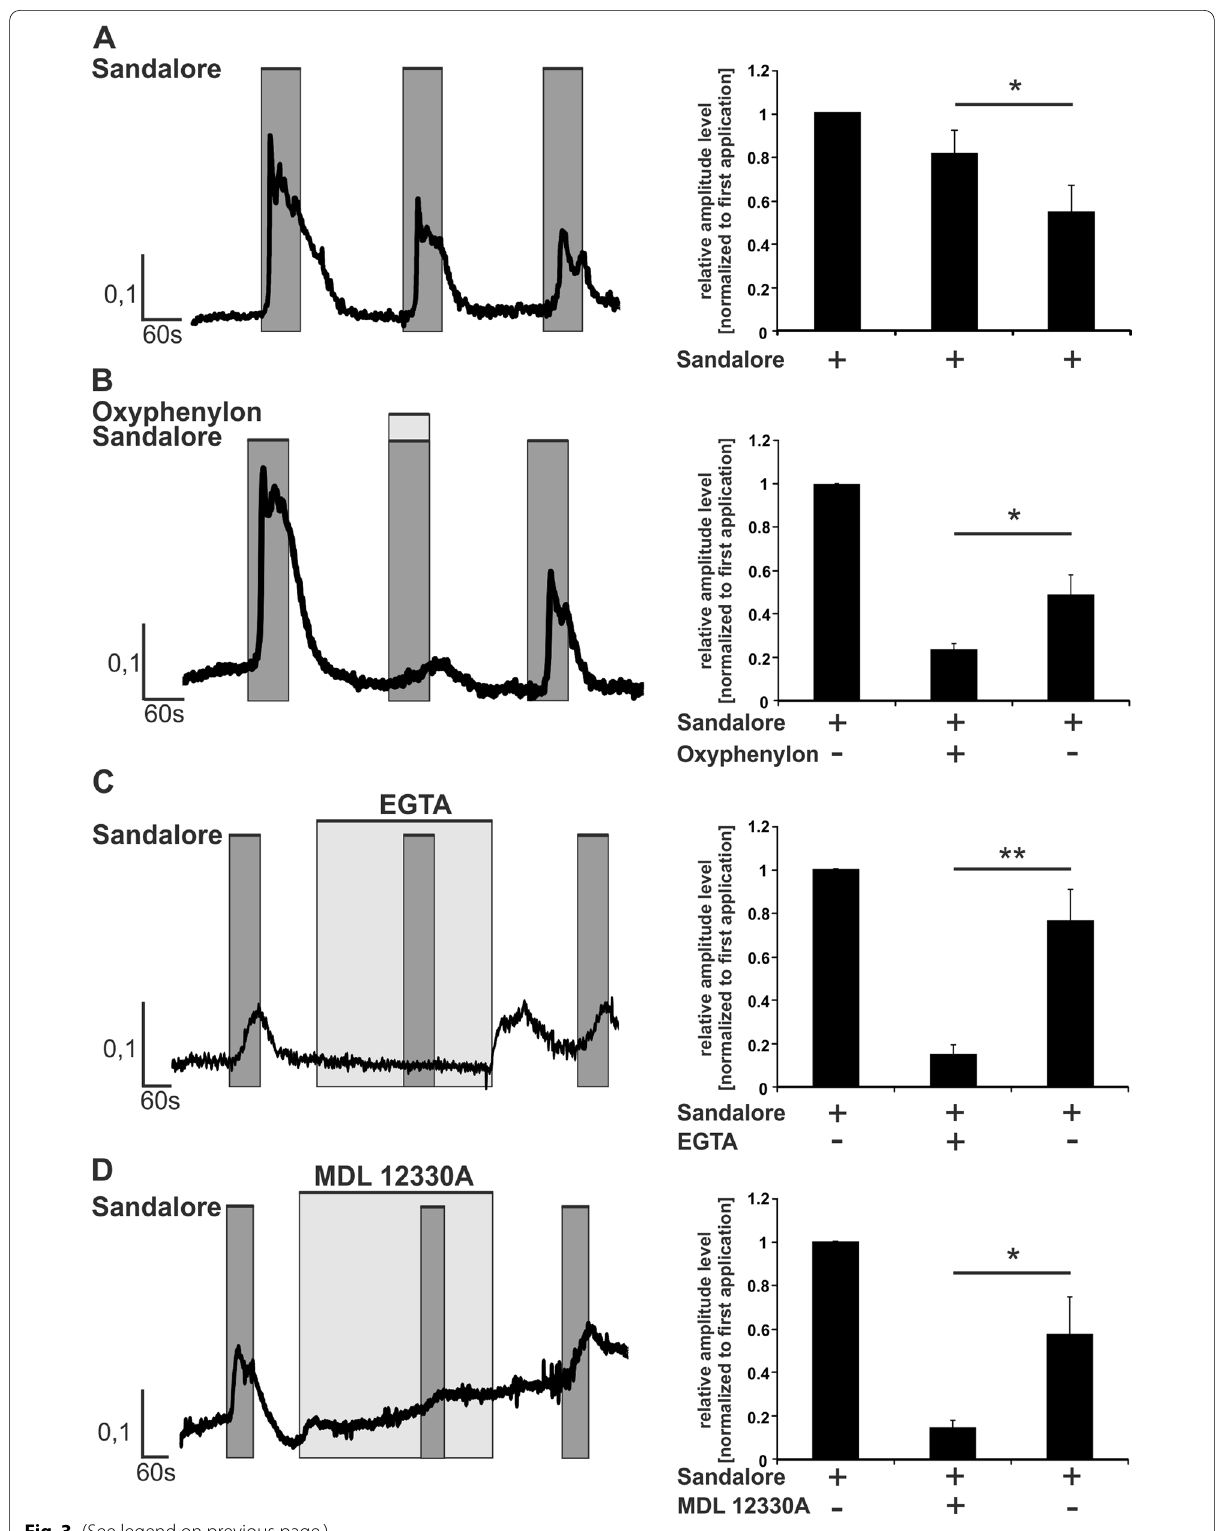
Fig. 3 (See legend on previous